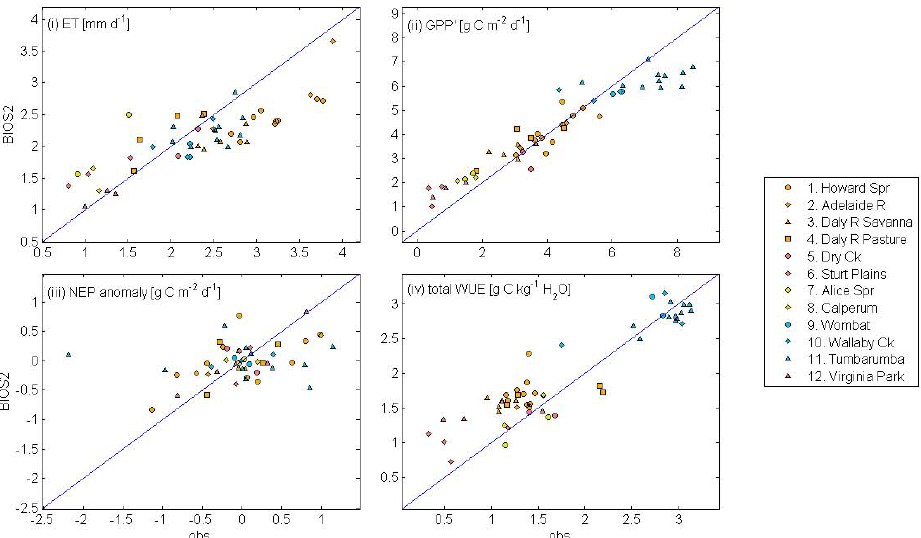
Fig. 8. Scatterplots of annual BIOS2 predictions vs Ozflux observations of (i) ET; (ii) GPP 0 ; (iii) NEP anomaly; and (iv) total WUE (=GPP 0